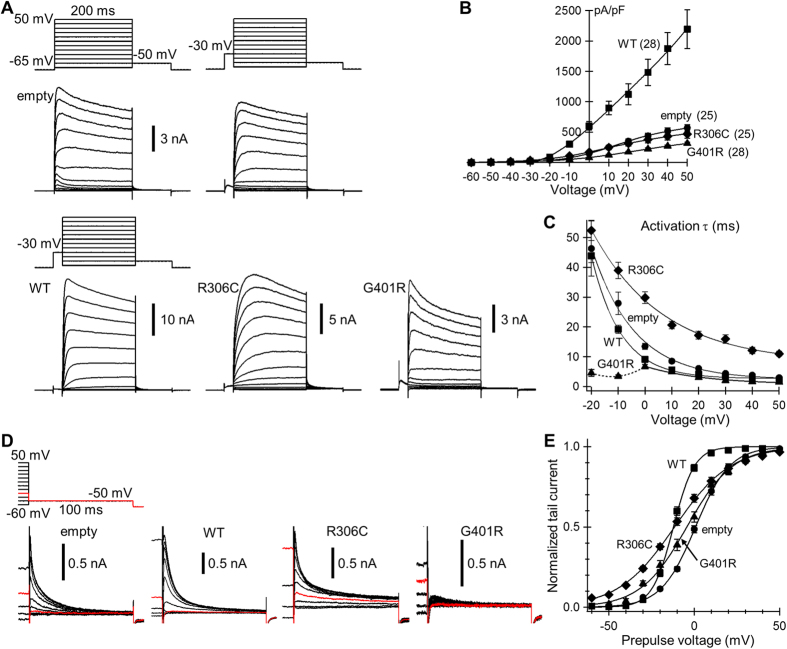
Voltage dependence of Kv activation in Kv2.1 mutant-transfected primary cortical neurons.(A) Representative Kv currents. Except the currents in the upper left, 25 ms prepulses to −30 mV were included to isolate IA. Note that the currents during the following voltage steps at –30 mV after the prepulses were noticeable only in R306C. (B) I–V relationships of peak currents. To include IA, prepulses were not applied. The current density at +50 mV in R306C (diamonds) did not differ from that in empty (circles, P = 0.83), whereas the density in G401R (triangles) and WT (squares) differed (P < 0.01). (C) Voltage dependence of τ. To exclude IA, prepulses were applied. τs were determined by fitting the initial current rising phase from 20% of the peak rise to single or double exponentials, depending on better fit. When currents were fitted to double exponentials, slower τs were plotted. τs at ≥ 0 mV in R306C were larger than in others (P < 0.01). τs at −20 and −10 mV in G401R (dotted line) were smaller than in others (P < 0.01). (D) Representative tail currents. The currents were elicited by a 100 ms test voltage step to −50 mV after 200 ms voltage steps ranging from –60 mV to +50 mV in 10 mV increments. Traces from the last 10 ms of 200 ms voltage steps are shown. Currents elicited by the step from –30 mV are highlighted in red. (E) Activation curves. Vh and Vs in empty (1.0 ± 1.0 mV and 9.7 ± 0.4 mV, respectively) differed from those in WT (Vh −11.9 ± 0.8 mV, P < 0.01; Vs 5.9 ± 0.4 mV, P < 0.01), R306C (Vh −11.1 ± 1.3 mV, P < 0.01; Vs 16.3 ± 1.0 mV, P < 0.01), and G401R (Vh −4.7 ± 1.6 mV, P < 0.05; Vs 12.9 ± 0.8 mV, P < 0.01). Vh in R306C did not differ from WT (P = 1.00), although Vs did (P < 0.01). All comparisons here were by Dunnett’s T3 test.